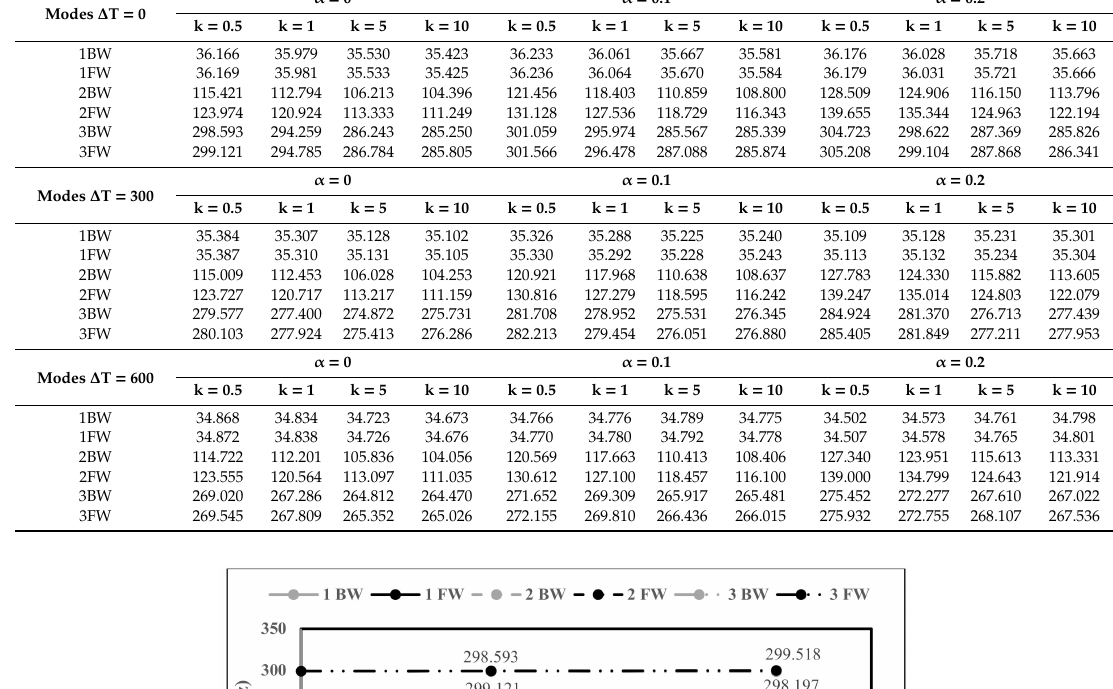
Table 8. Whirl frequencies of a porous FG rotor–bearing system for di ff erent values of k, α and ∆ T. Modes ∆ T = 0